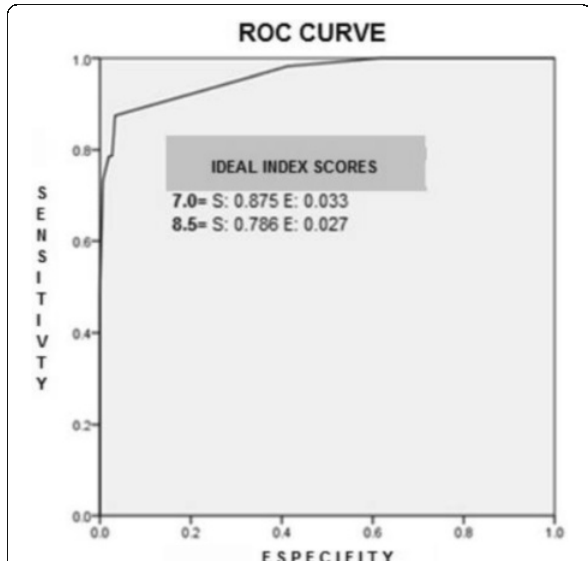
Table 102 (abstract A324). Risk factors selected for the predictive model